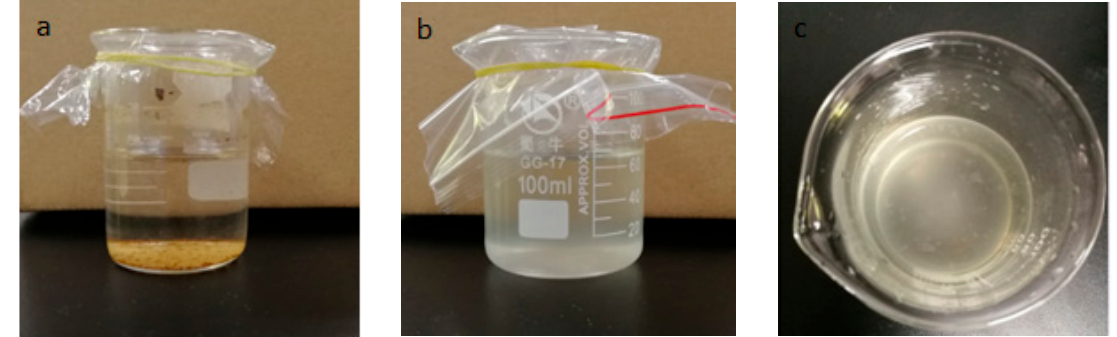
Figure 2. ( a ) The supernatant of oily sludge. ( b , c ) Culture medium containing the bacteria.